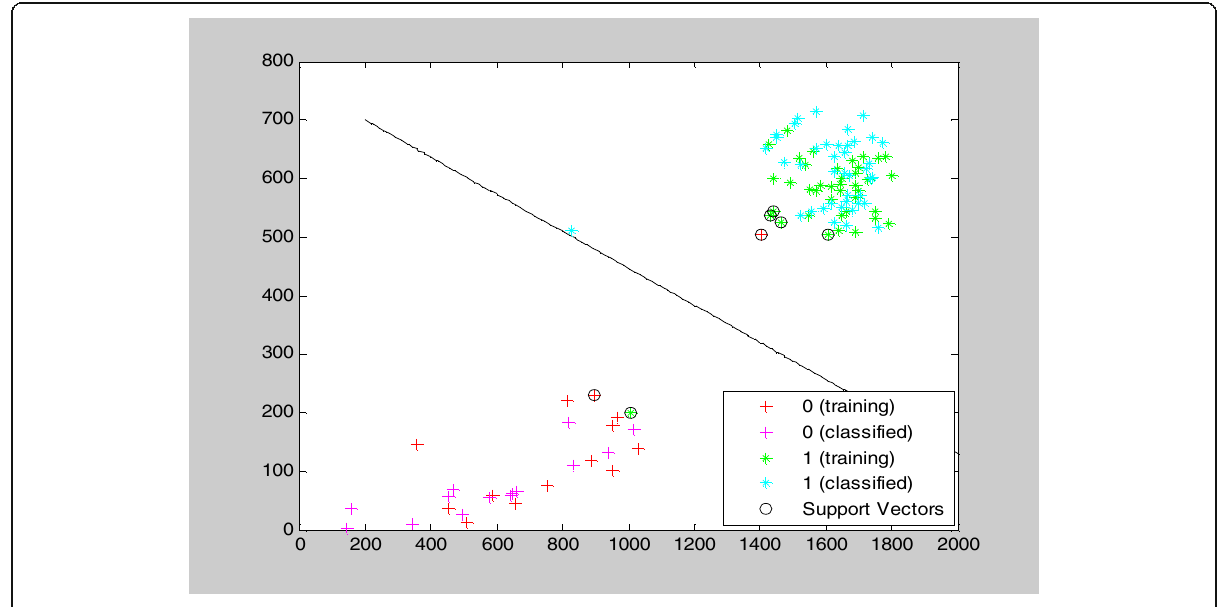
Fig. 7 SVM classification for area